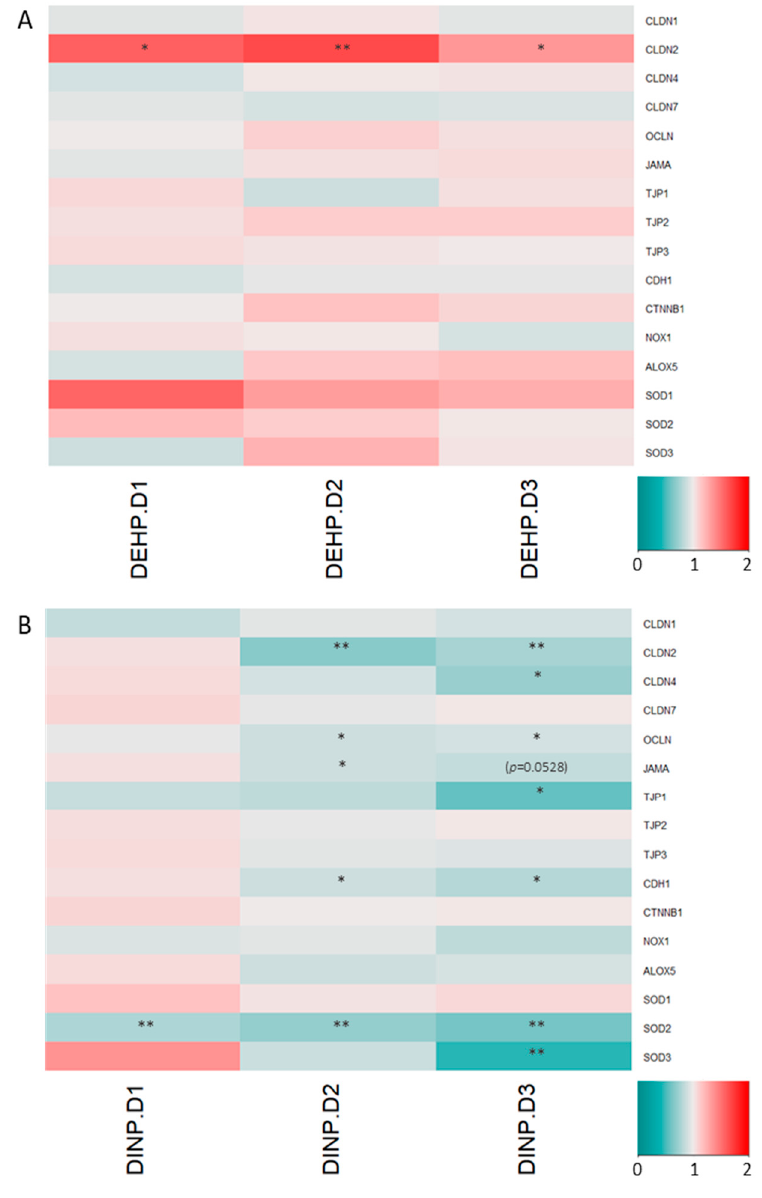
Figure 6. Relative quantification of TJ/AJ- and ROS-related gene mRNA levels in HT-29 after treatment of ( A ) DEHP experiment fermenters’ extracts and ( B ) DINP experiment fermenters’ extracts. Expression in cells treated with luminal extracts from no plasticizer fermenter was normalized as 1. t-test, * p < 0.05, and ** p < 0.01.